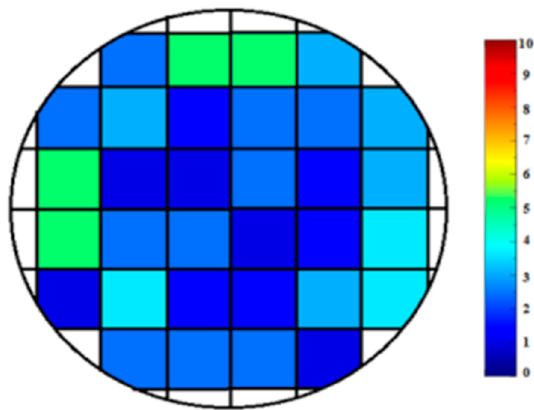
Figure 3. Non-destructive (ultrasonic) analysis of an SPS-joined (3Y)-TZP/(3Y)-TZP specimen. Ultrasonic wave reflections were translated into a colorimetric/numeric/scale reflecting bonding quality (0/blue: high bonding quality, 10/red: low bonding quality).